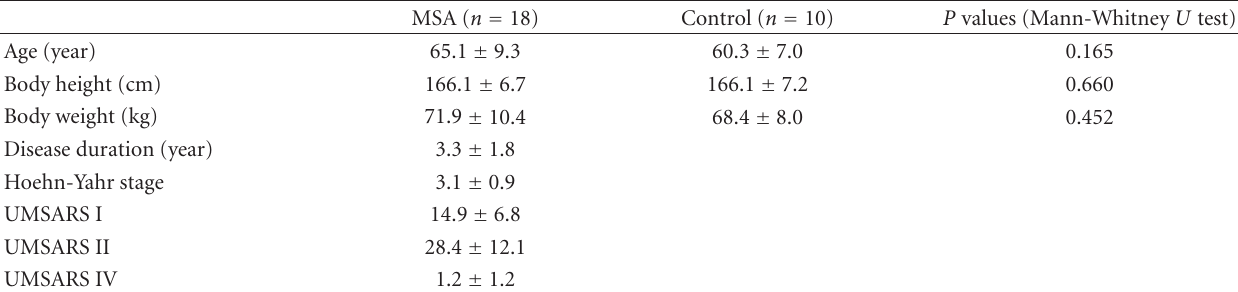
Table 1: Basic characteristics in patients with multiple system atrophy (MSA) and healthy controls.